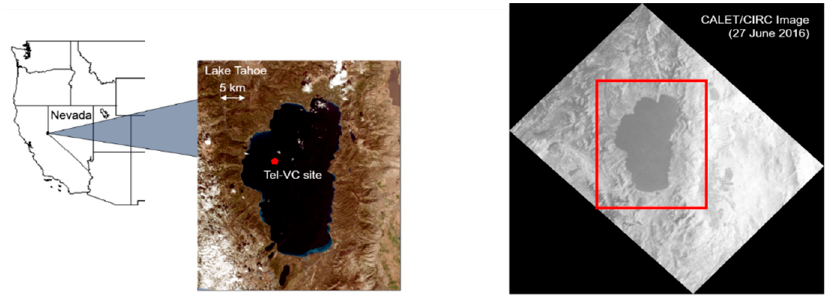
Figure 7. Location of the Tel-VC site in Lake Tahoe (left) and the CALET/CIRC image acquired over the lake on 27 June 2016 (right).